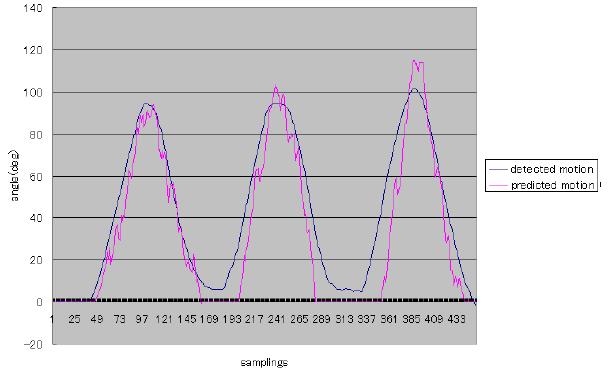
Figure 17. The typical elbow flexion and extension for S2.